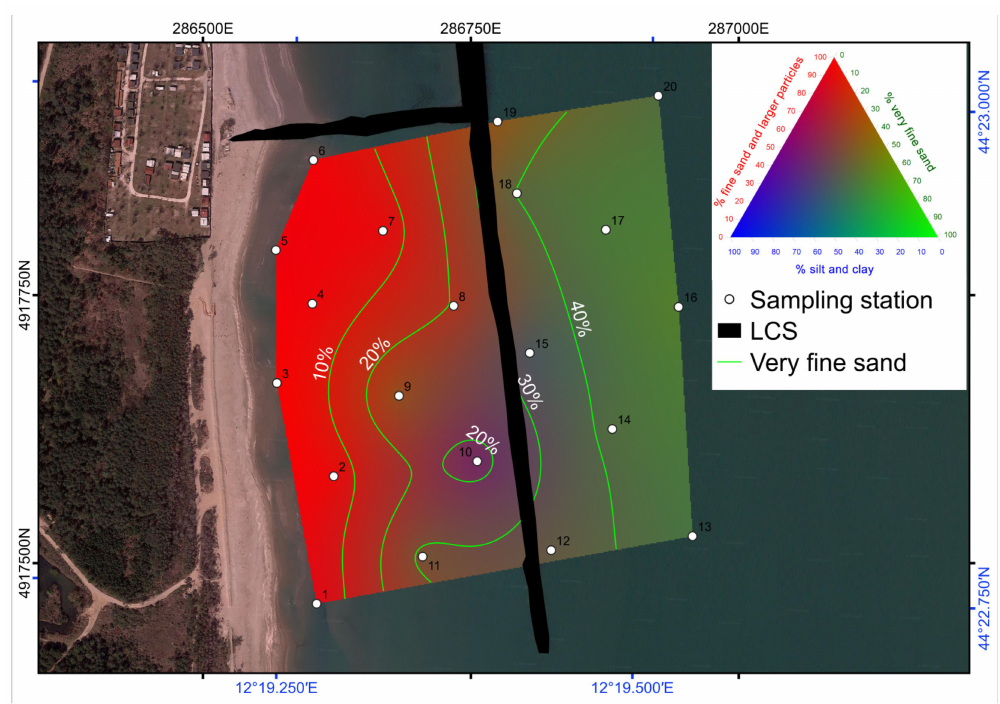
Figure 7. Grain-size distribution in the study area. Proportions of the three main grain-size classes are represented using a ternary color scale (red = fine sand and larger particles, green = very fine sand, blue = silt and clay). Sampling stations are indicated by white circles numbered from 1 to 20. Contour lines are based on the percentage of very fine